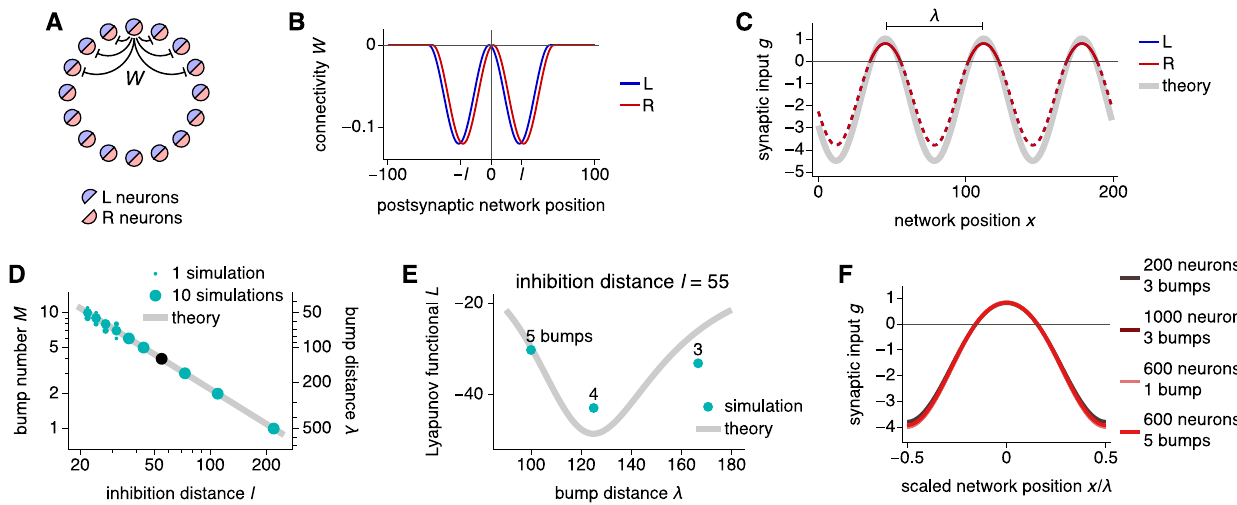
Fig 2. Bump formation in a ring attractor network. ( A ) Network schematic with populations L and R and locally inhibitory connectivity W . ( B and C ) Networks with 200 neurons and 3 bumps. ( B ) Connectivity weights for a neuron at the origin. The inhibition distance is l = 29 and the connectivity shift is ξ = 2. ( C ) Steady-state synaptic inputs. Curves for both populations lie over each other. With a ReLU activation function, the firing rates follow the solid portions of the colored lines and are 0 over the dashed portions. The bump distance is λ = 200/3. Thick gray line indicates Eq 4. ( D and E ) Networks with 500 neurons. ( D ) More bumps and shorter bump distances are produced by smaller inhibition distances. Points indicate data from 10 replicate simulations. Line indicates Eq 5. ( E ) The inhibition distance l = 55 corresponds to the black point in D with λ = 125 and M = 4. These values also minimize the Lyapunov functional (Eq 6), which varies smoothly across λ for infinite networks (line) and takes discrete values for finite networks (points). ( F ) The scaled bump shape remains invariant across network sizes and bump numbers, accomplished by rescaling connectivity strengths according to Eq 7. Curves for different parameters lie over one